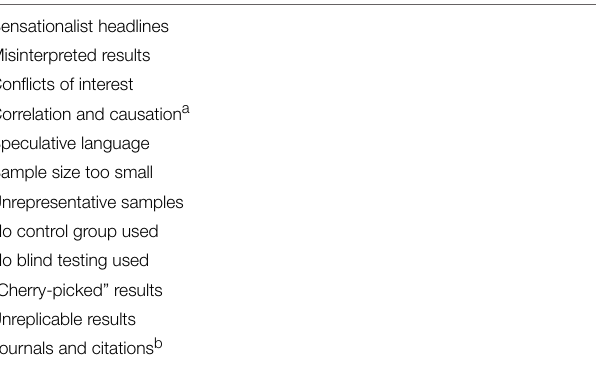
TABLE 1 | A “bad science”